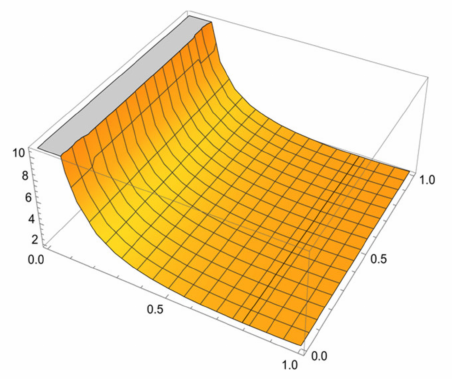
Figure 3. The graph of the surface solution f ( x , t ) of the IVP in Example